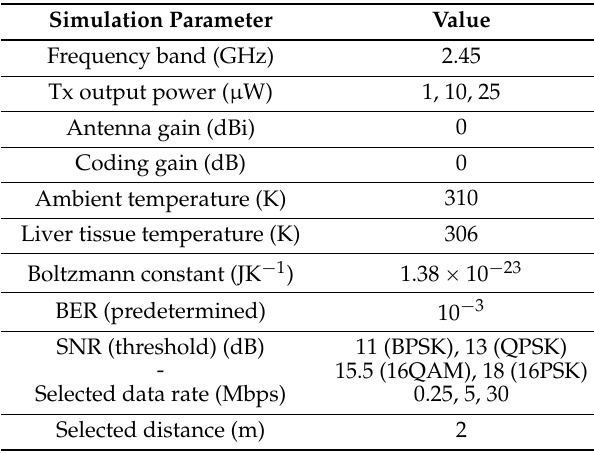
Table 4. Parameters for the Link Budget Simulations.